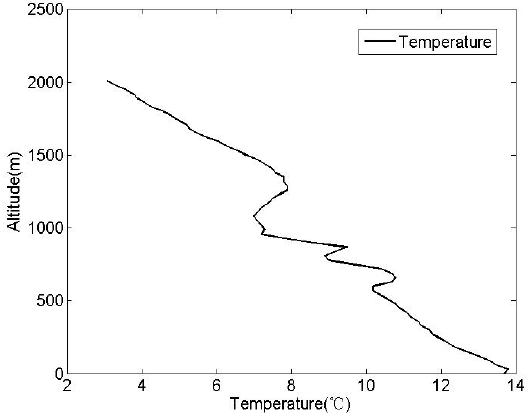
Figure 3. Radiosonde temperature profile at 08:00 on 3 October 2014.